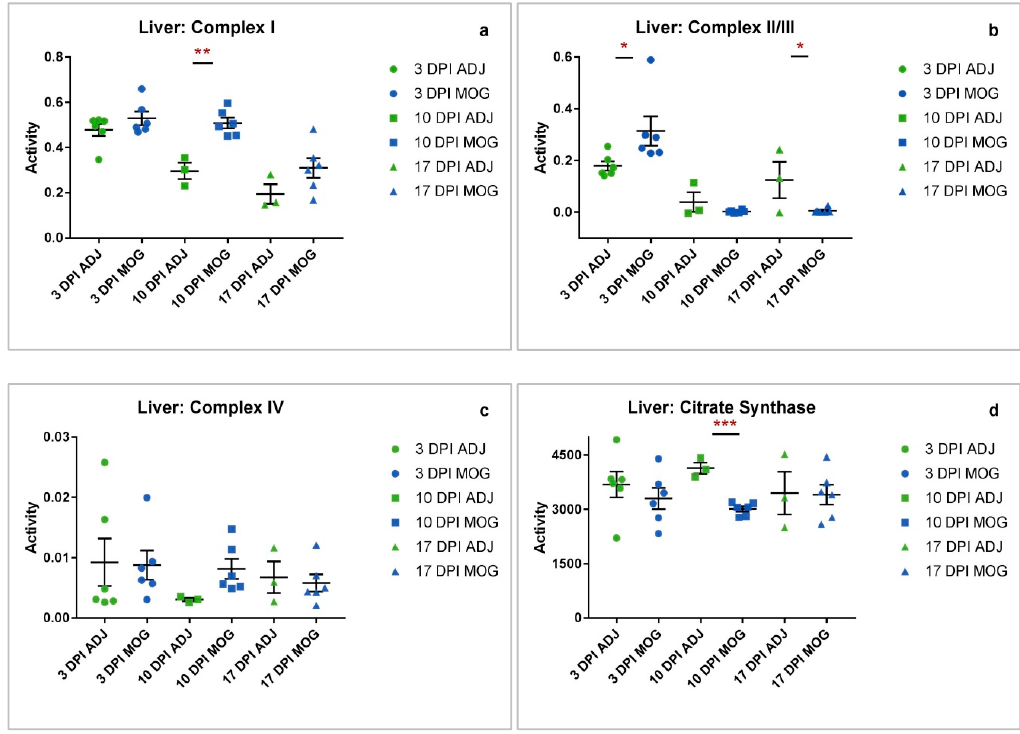
Figure 3. Liver complex activity ADJ vs MOG at different time-points. Individual raw data points for controls (ADJ) (green) and diseased (MOG) (red) have been plotted with mean and standard error of mean (SEM) to show the distribution of complex activity. Activities shown are expressed as a ratio to CS activity. ( a ) Graph showing distribution of complex I activity across ADJ and MOG. Complex I activity in MOG animals was significantly increased at 10 DPI (** p = 0.0014). ( b ) Complex II/III activity